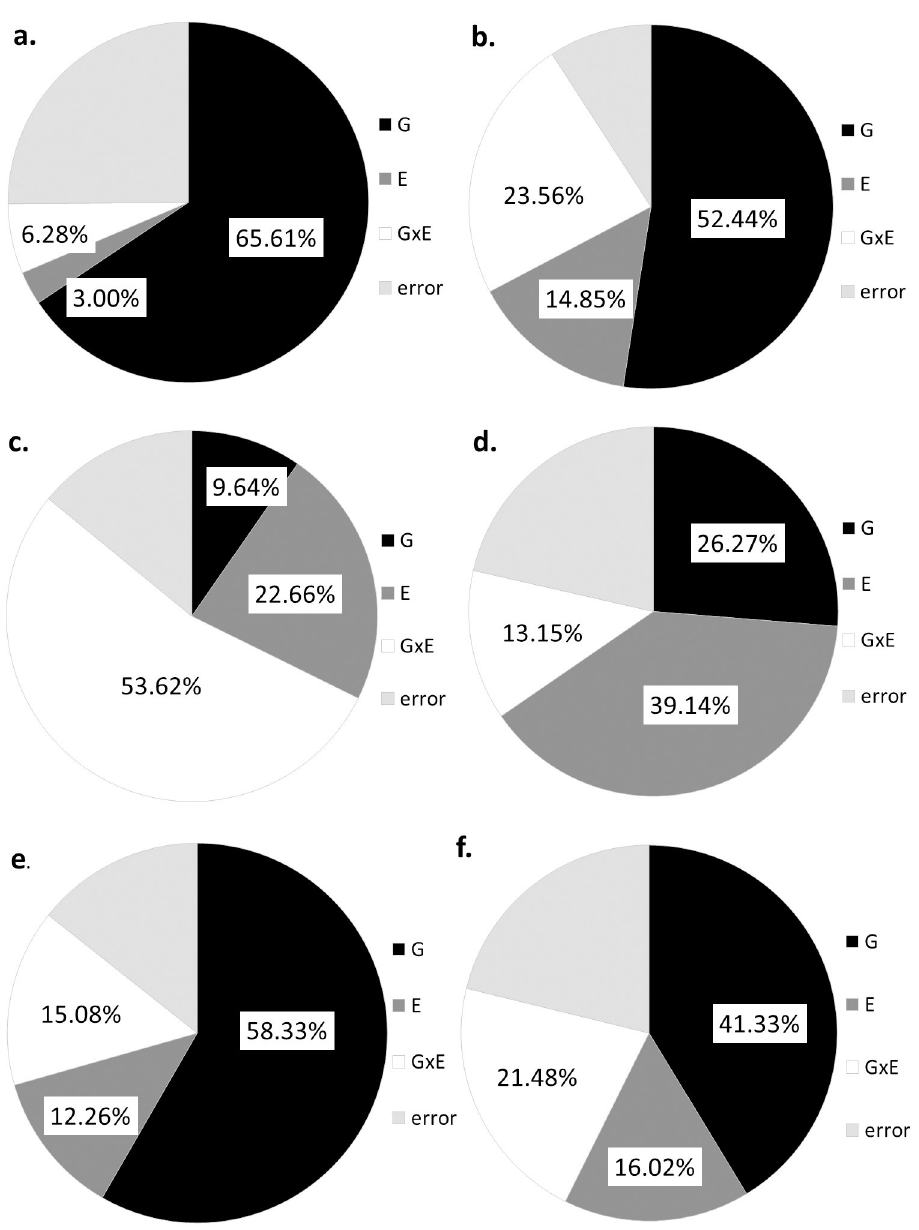
Fig 1. Variance components determined for some compositional traits of the 31 breeding lines and their controls. (a. protein content, b. starch content, c. total pentosan content (TOT pentosan), d. water-extractable pentosan content (WE-pentosan), e. water-extractable arabinoxylan content (WE-AX), f. arabinose/xylose ratio in WE-AX (A/X ratio) (2013–2015).